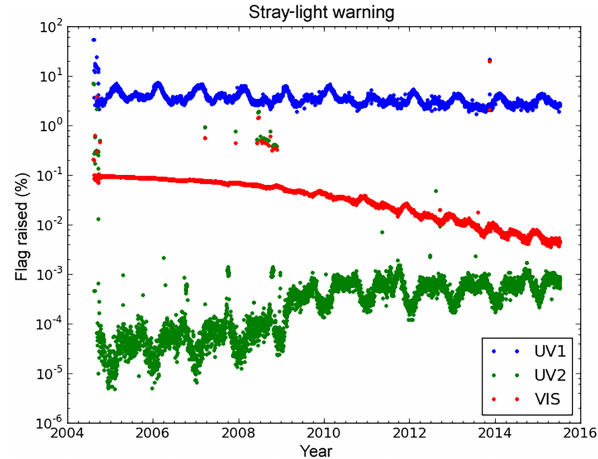
Figure 19. Stray-light warning trend over the